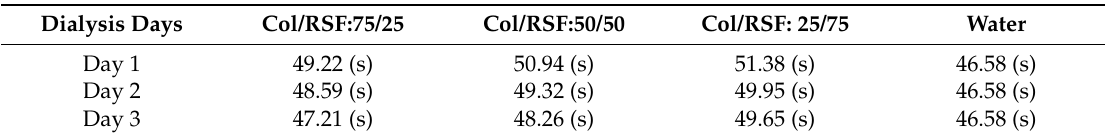
Table 4. Passing time (s) of the collagen/RSF solutions after filtrations (all the ratios are those before